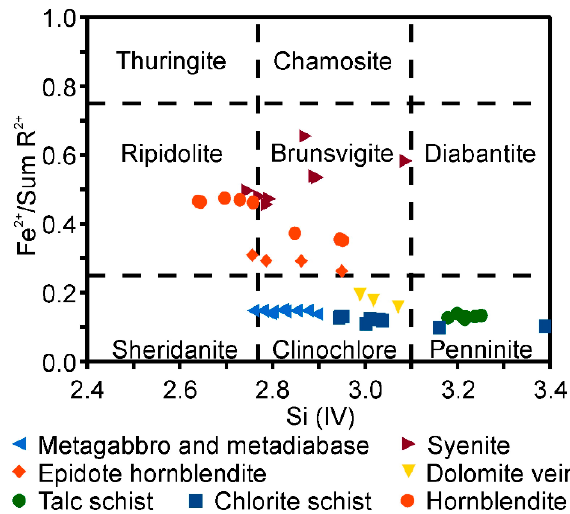
Figure 7. Chlorite-group minerals composition at the chlorites classification diagram of Foster [46], with modifications by Esteban et al. [47].